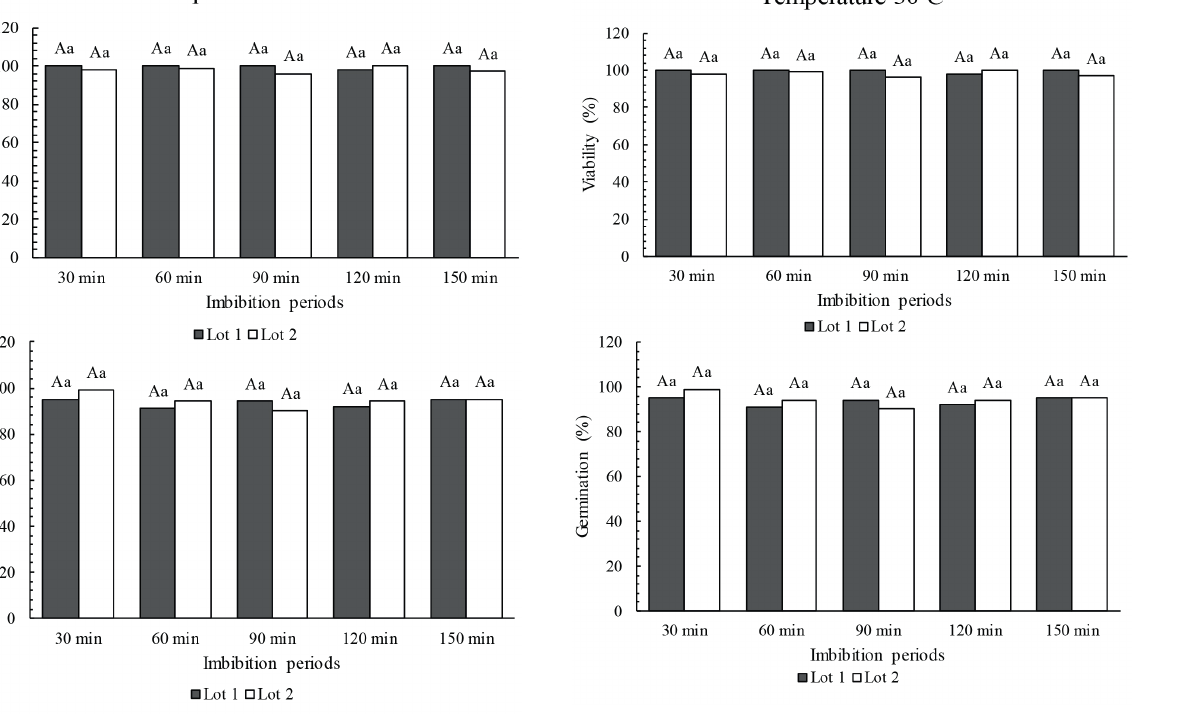
Figure 2 - Percentage of viability and germination by pH test of the exudate pH of two seed lots of Libidibia ferrea at 30ºC as a function of imbibition periods. *Means followed by the same lowercase letter in the line do not differ statistically from each other by the Tukey test at 5% probability.